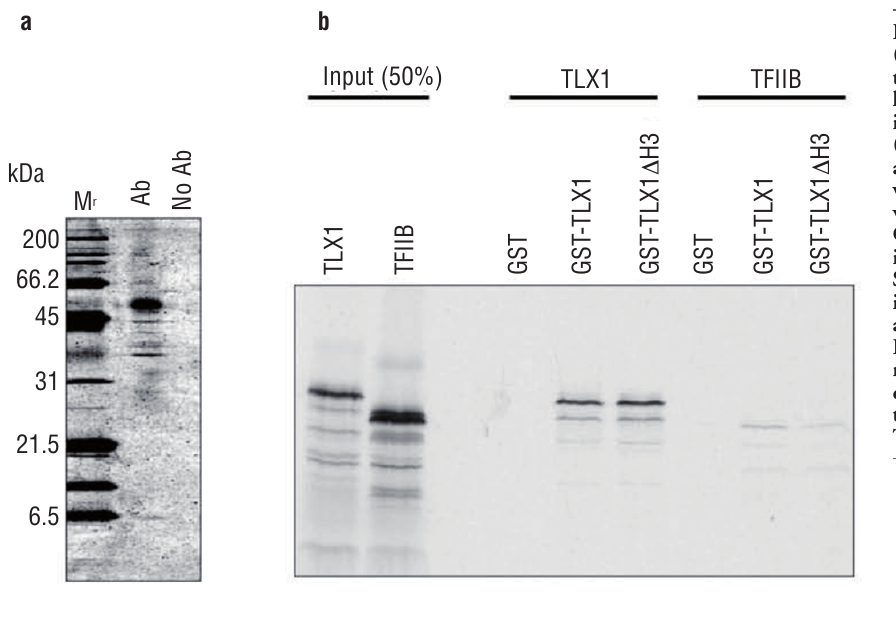
Table 1. Proteins identified by immunoprecipitation and peptide mass fingerprinting.